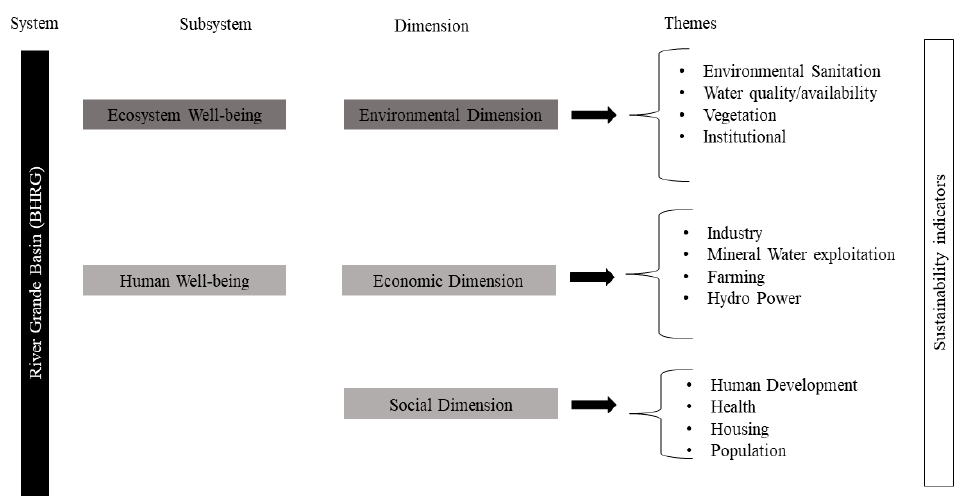
Figure 3. Sustainable development indicators’ organization in each subsystem, dimension, and theme.